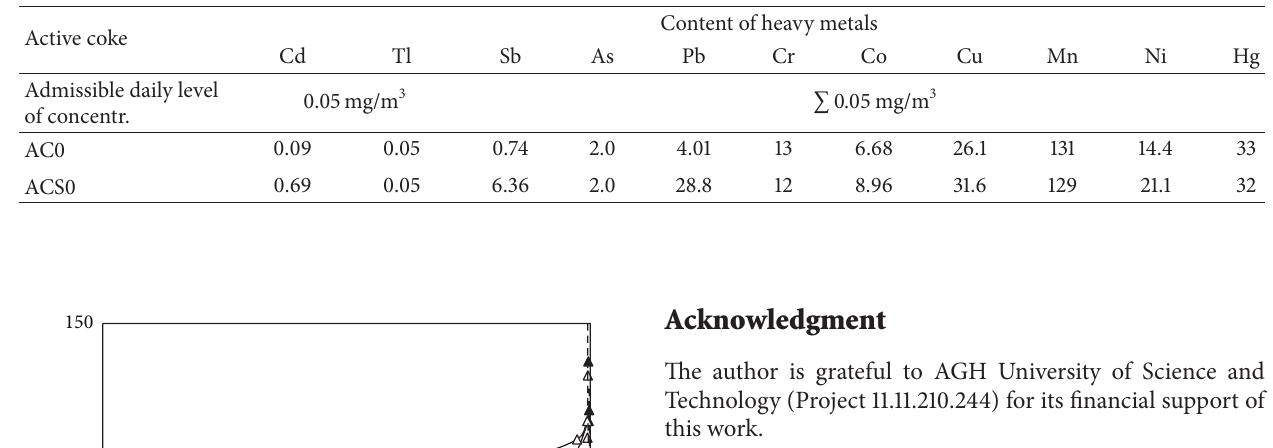
Table 4: Contents of selected heavy metals in active coke samples.